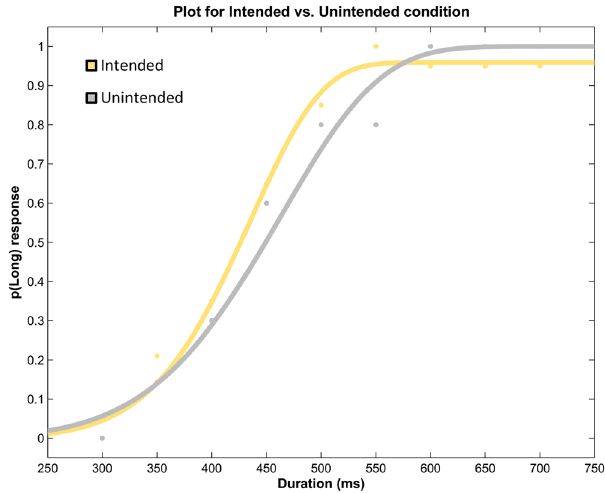
Figure 3. Plot depicting the fitted psychometric function (Weibull) for the intended and unintended conditions of a representative participant from Exp 1.